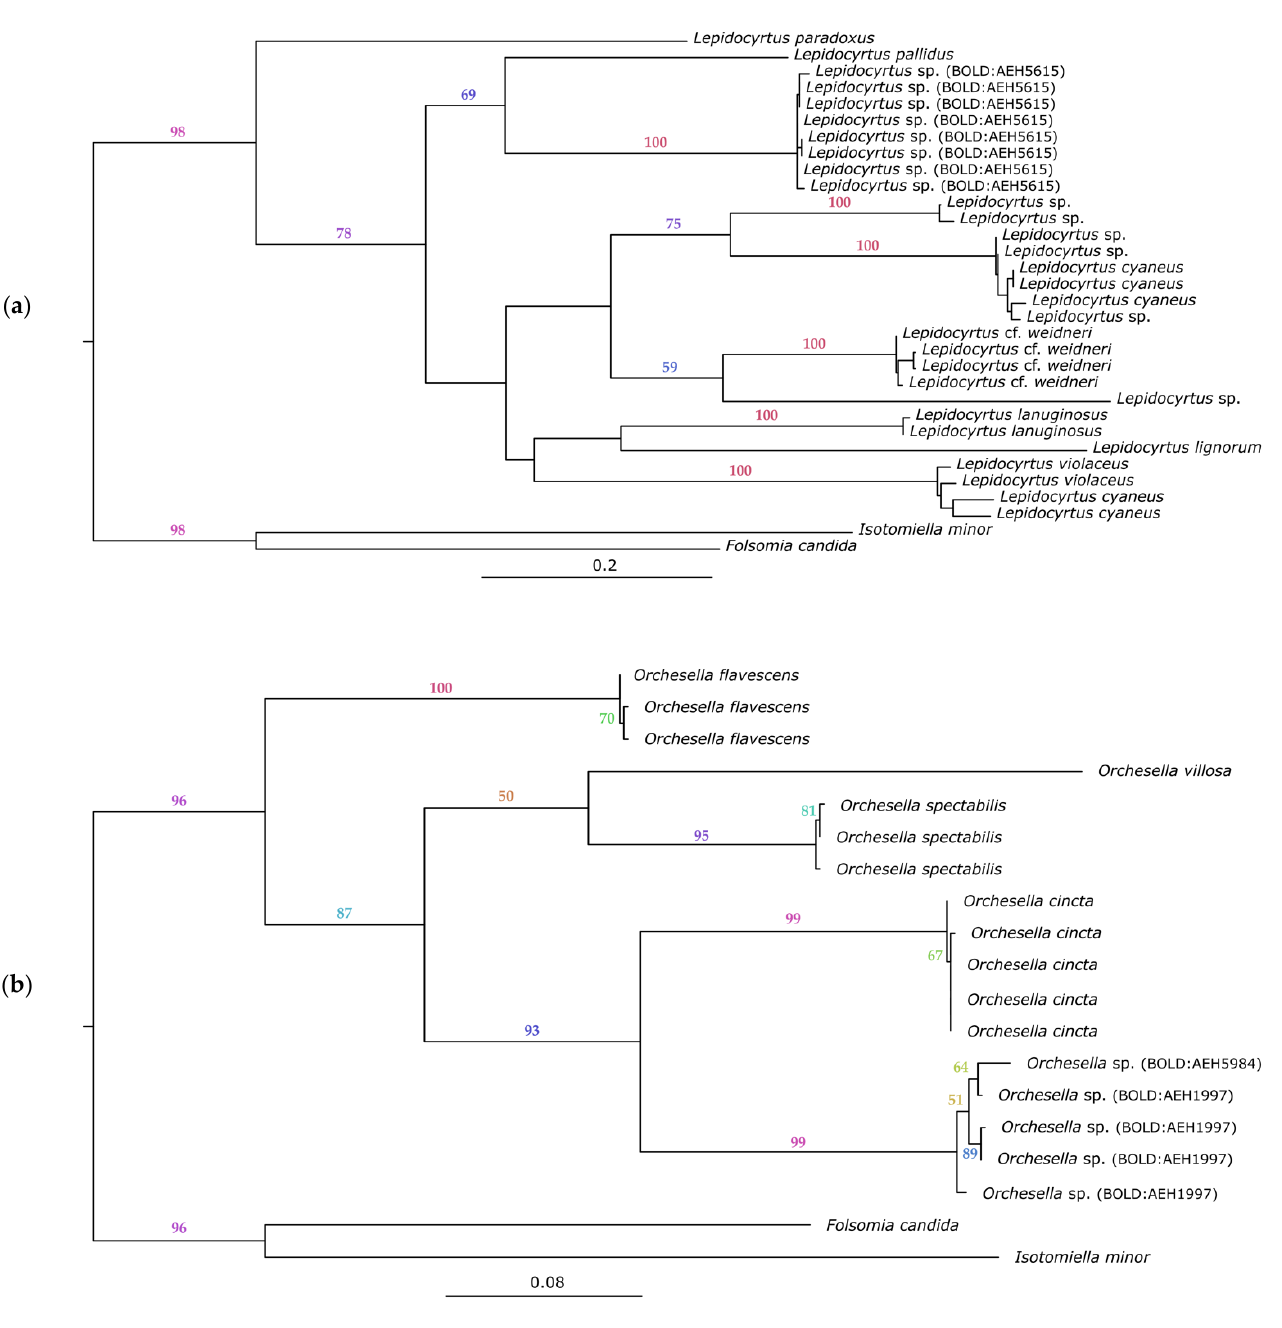
Figure 5. Maximum likelihood phylogram inferred for specimens of the genus Lepidocyrtus ( a ) and the genus Orchesella ( b ). Numbers on the branches represent the nonparametric bootstrap support ( ≥ 50). The trees are rooted on Folsomia candida (BOLD:AAB6463) and Isotomiella minor (BOLD:ACQ1061) as outgroups.